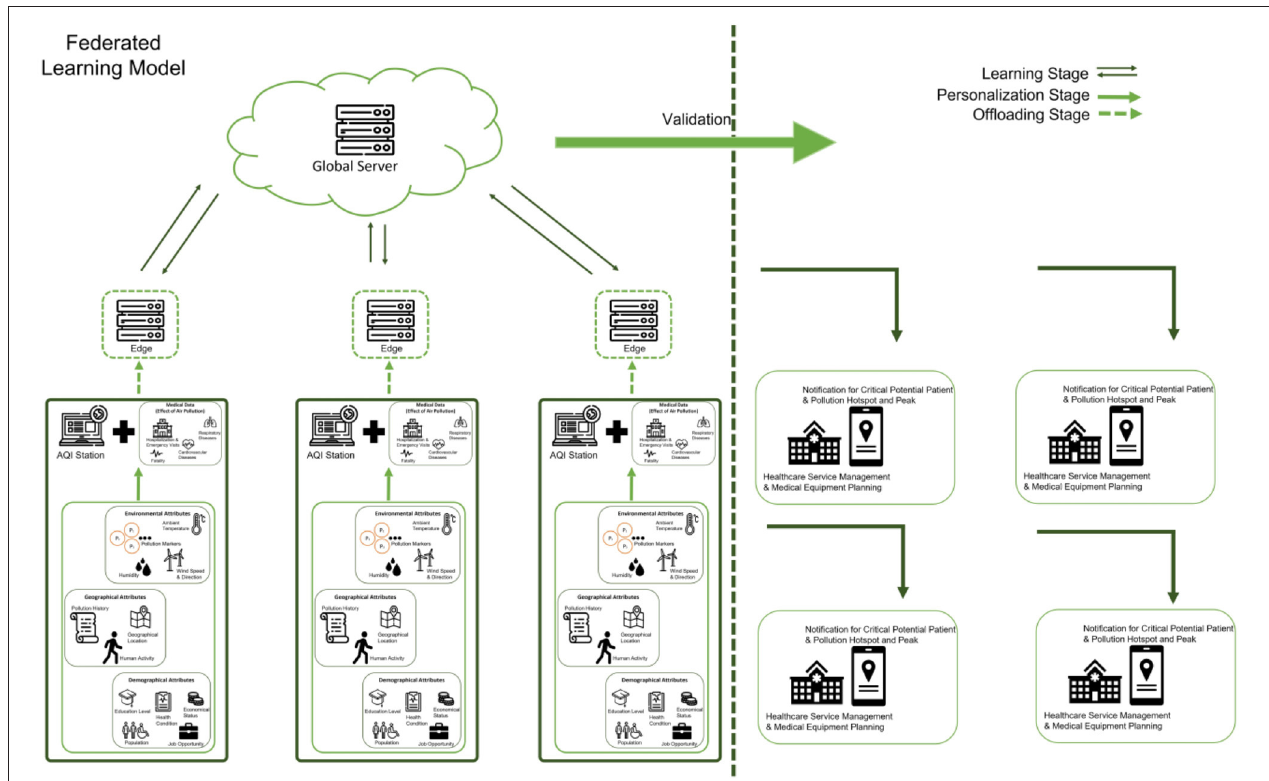
FIGURE 2 | Framework of integrated environmental and health impact assessment.